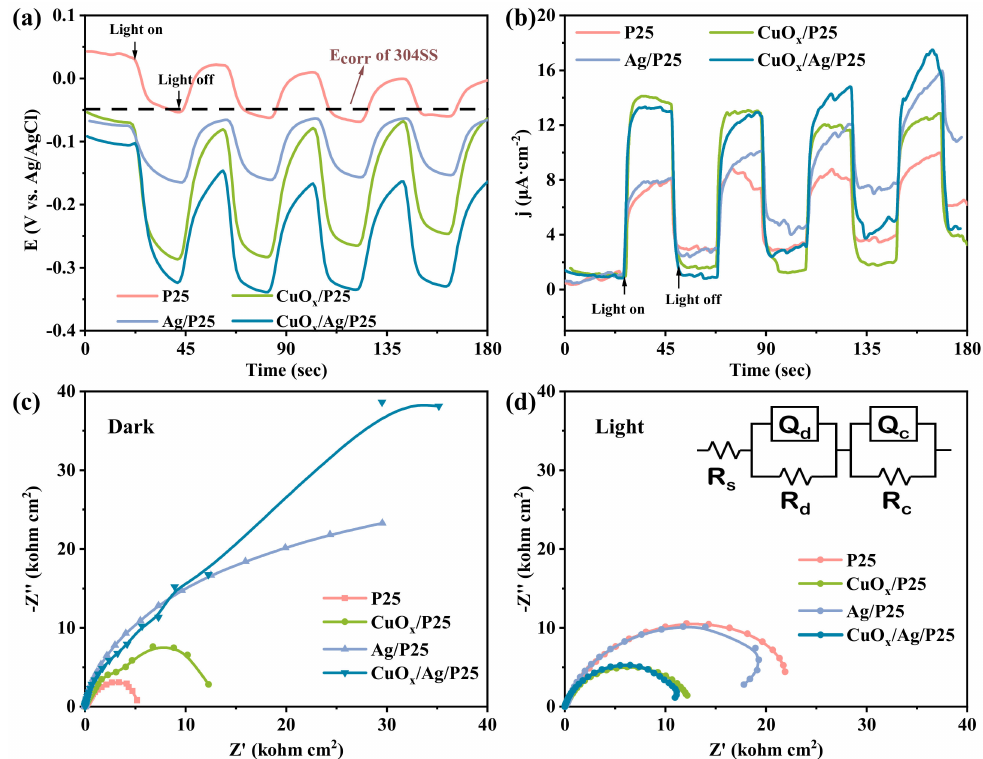
Figure 5. ( a ) The photoinduced OCP − time curves and ( b ) i − t curves of P25, CuO x /P25, Ag/P25, and CuO x /Ag/P25 coupled with 304SS. Nyquist plots measured ( c ) in the dark and ( d ) under illumination. Insert of ( d ) is the corresponding equivalent